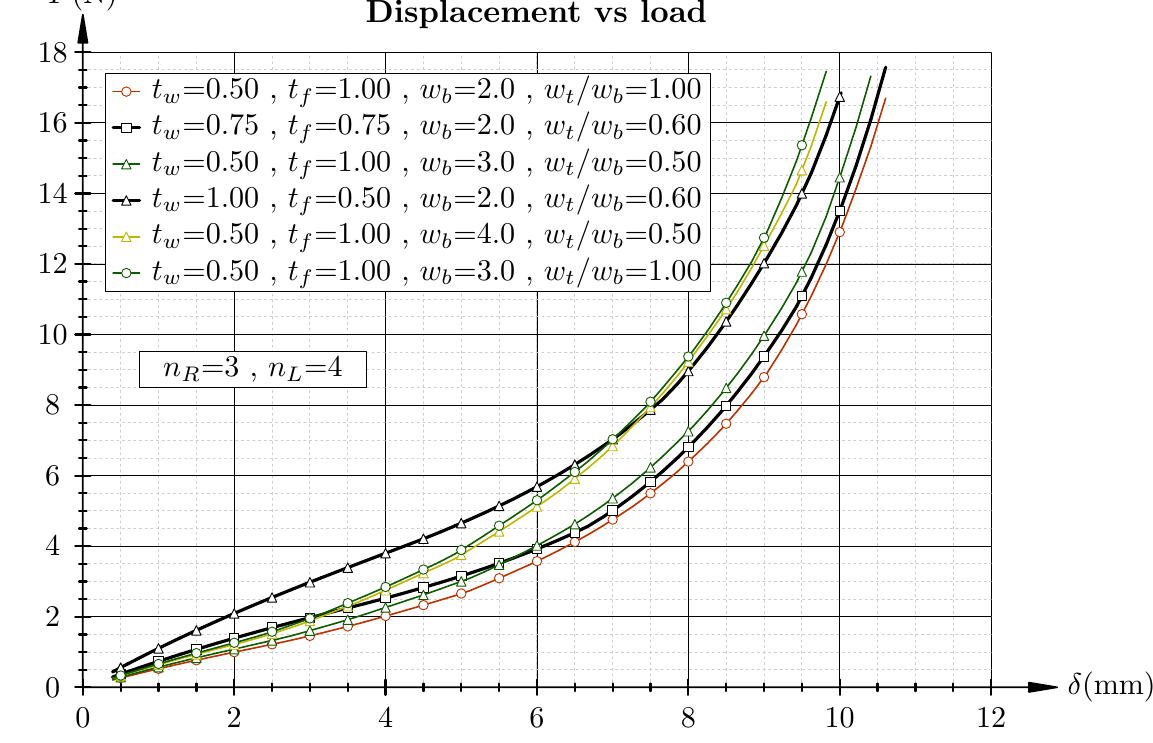
Figure 12. Comparison of different radial compression force within different